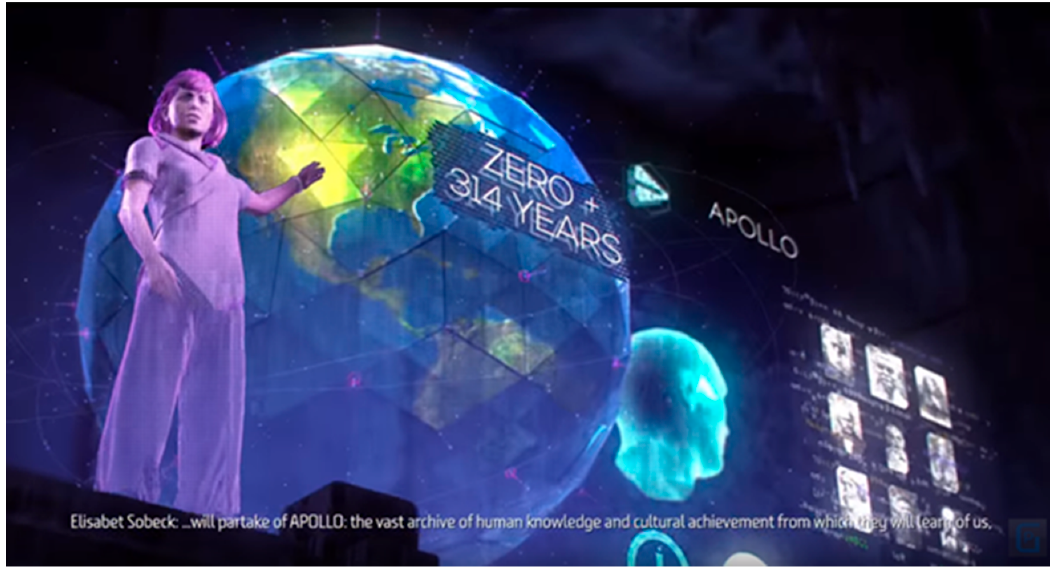
Figure 12. A hologram explains the educational APOLLO archive. Religions 2017 , 8 , x FOR PEER REVIEW